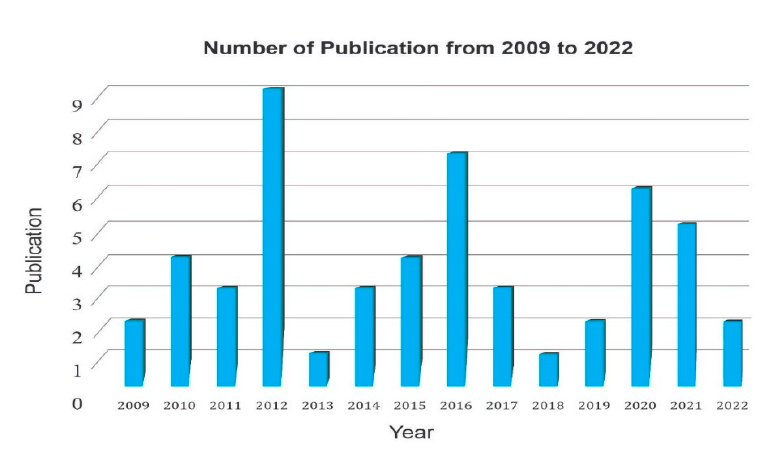
Figure 3. Publications from 2009 to 2022 based on the collected database.